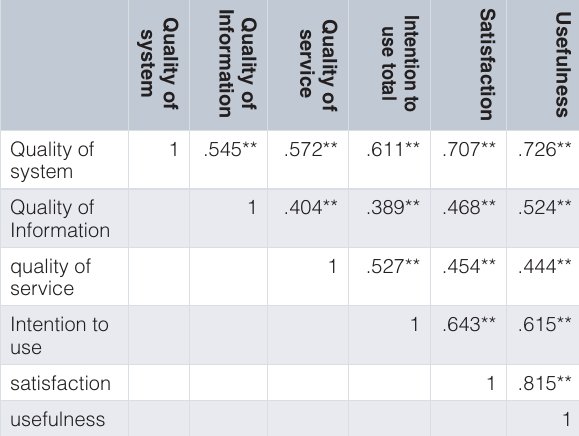
Table 2. The correlation between the variables used in the evaluation of the education